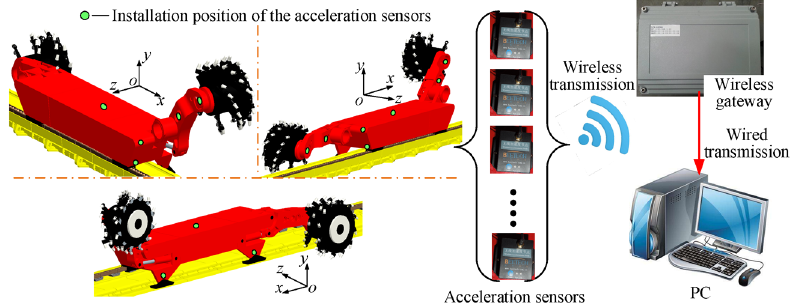
Figure 10. The data acquisition system of vibration acceleration for key parts of the shearer.